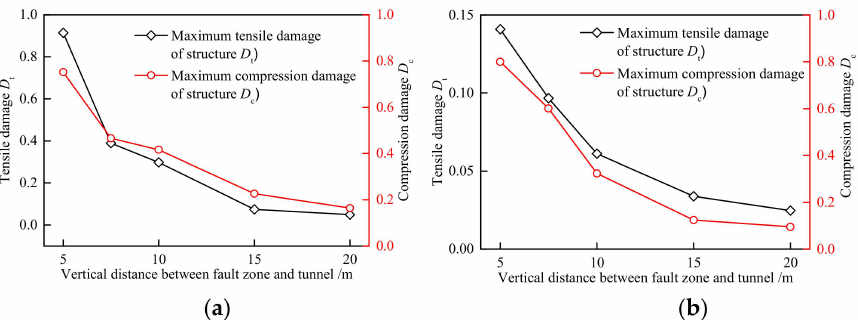
Figure 20. Effect of the vertical distance h on the structural damage of segmental lining: ( a ) normal faulting condition and ( b ) reverse faulting condition.